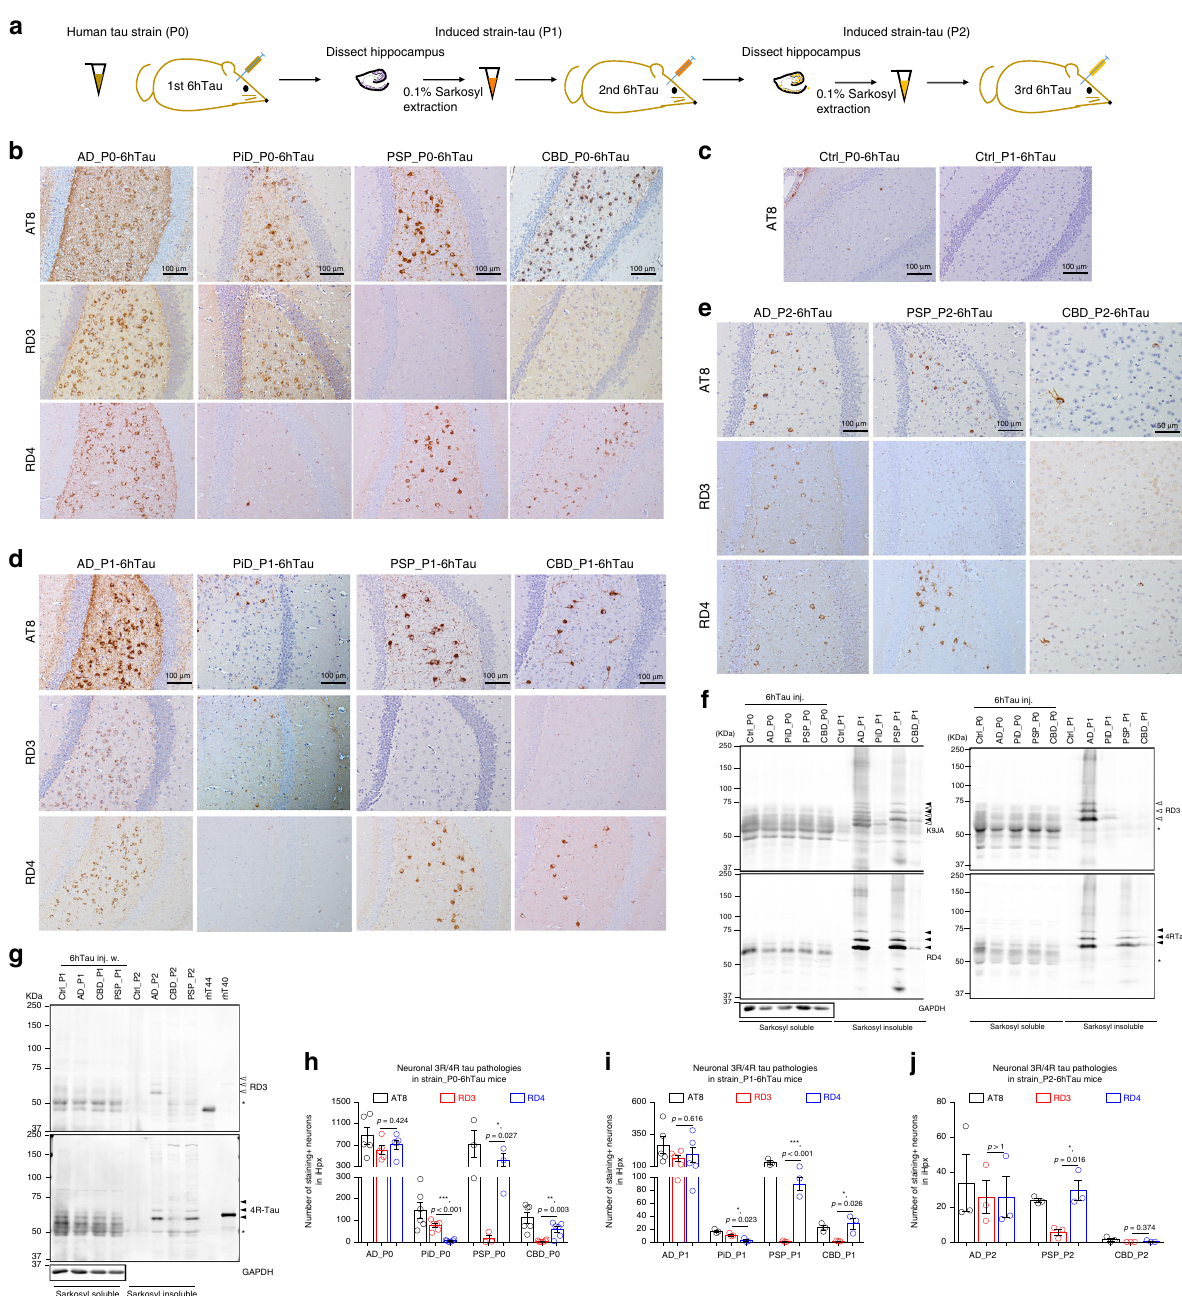
Fig. 2 Isoform-speci fi c seeding pattern is unaltered during repeated propagation. a Schematic showing in vivo propagation paradigm in 6hTau mice. Similar amounts of human tau strains (P0) were injected into the hippocampus of naive 6hTau mice for 1st round transmission and 3 months later, the hippocampi were dissected and extracted using detergent to obtain the induced tau strain (P1). The P1 tau strain was re-injected into the hippocampus of naive 2nd round transmission 6hTau mice, and the induced P2 tau pathologies were extracted similarly as P1 and injected into the hippocampus of 3rd round of 6hTau mice. Representative IHC staining in panel b using MAbs AT8, MAb RD3 (3R isoform tau-selective) and MAb RD4 (4R tau isoform- speci fi c) on adjacent brain sections from 6hTau mice injected with equal amounts of P0-tau from different human tau strains; or c with control lysate from normal human brains Ctrl_P0 or non-injected aged 6hTau mouse brains Ctrl_P1; or d with induced P1-tau; or e with induced P2-tau at 3 m.p.i. The P1 injection doses were 0.1 – 0.5 μ g per site, and P2 were 0.01 – 0.03 μ g per site, while the P0 were 1 μ g per site. Biochemical extraction of induced f P1 from strain_P0 – 6hTau and g P2 from strain_P1 – 6hTau mice with 0.1% sarkosyl. The sarkosyl-insoluble tau were probed with Mab RD3, Mab RD4, and polyclonal anti-4R Tau-speci fi c antibody to examine the isoform compositions in the induced pathologies. Open arrowheads indicate 3R Tau immunobands, and solid arrowheads indicate 4R Tau bands. Asterisks indicate the non-speci fi c immunoreactive bands near 50 KDa, respectively, shown in RD3 and 4RTau blots. Equal proportion of sarkosyl-soluble fractions were loaded, and f 15-fold fraction from strain_P1 or g 40-fold fraction from strain_P2 mice were loaded as sarkosyl-insoluble fraction. h Quanti fi cation of b from strain_P0; i quanti fi cation of d from strain_P1, and j quanti fi cation of e from strain_P2 induced neuronal tau pathologies, respectively, indicated by AT8, RD3, and RD4. Only ipsilateral hippocampus (iHpx) were quanti fi ed for each mouse. Data are presented as mean ± s.e.m. n = 3 – 6 mice per each group. Multiple t -tests were performed. Source data is available as a Source Data fi